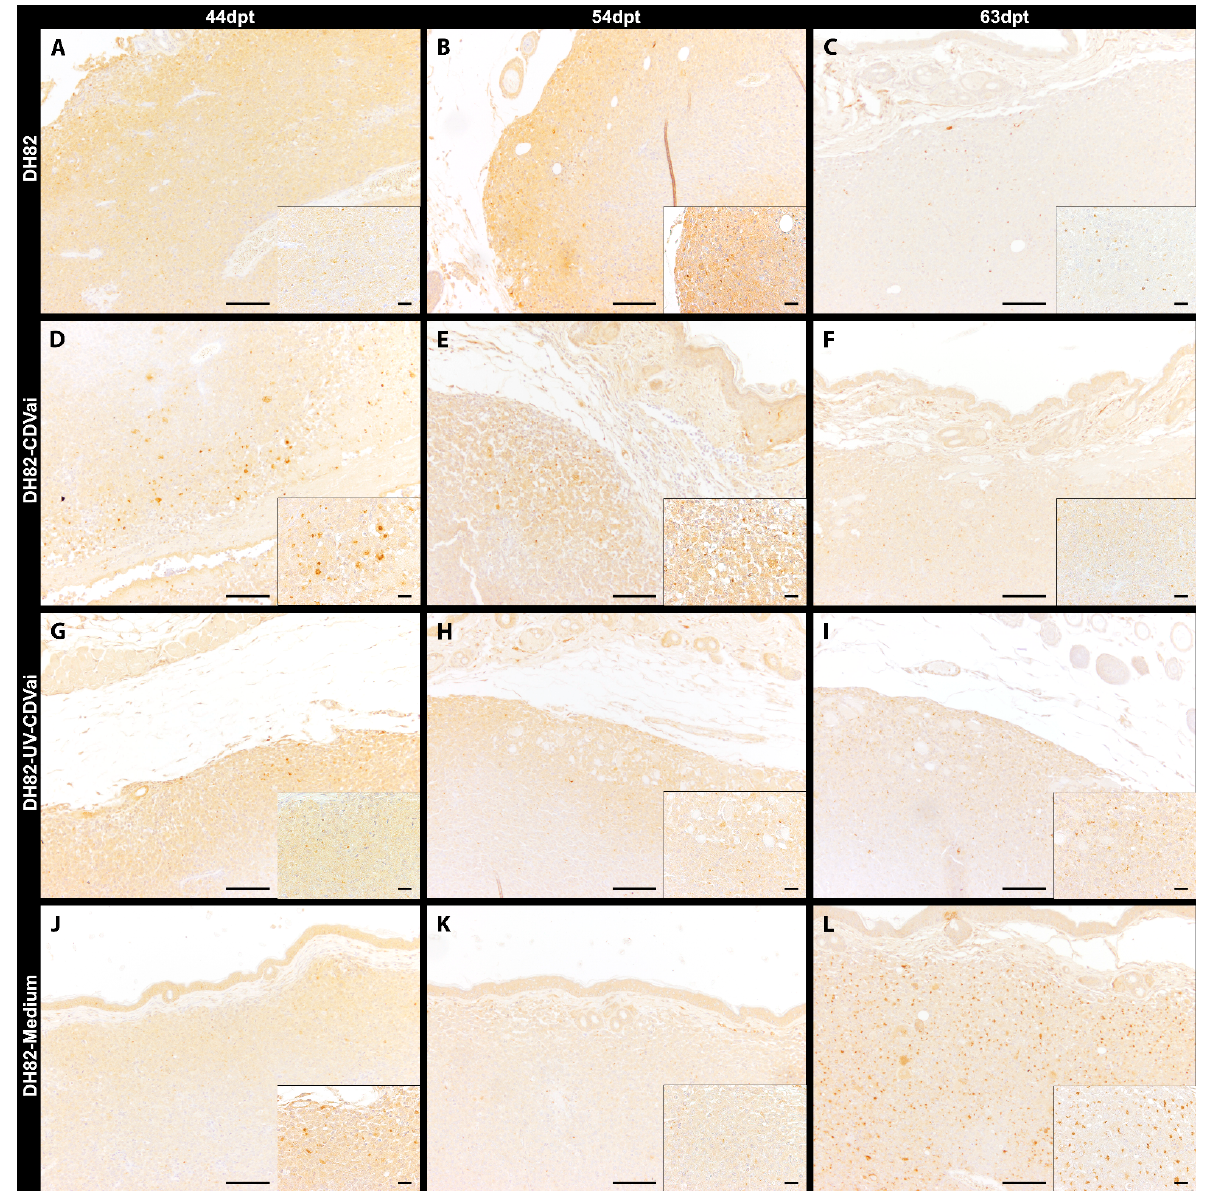
Figure 6. Peripheral MMP-9 immunolabeling in murine subcutaneous DH82 cell xenografts ( A – L ). ( A – C ) display non- infected (DH82), ( D – F ) intratumorally canine distemper virus (CDV)-infected (DH82-CDVai), ( G – I ) intratumorally UV- inactivated CDV-injected (DH82-UV-CDVai) and ( J – L ) intratumorally medium-injected (DH82-medium) neoplasms at ( A , D , G , J ) 44 days post-transplantation (dpt), ( B , E , H , K ) 54 dpt and ( C , F , I , L ) 63 dpt. Scale bar = 100 μ m and scale bar— insert = 20 μ m.